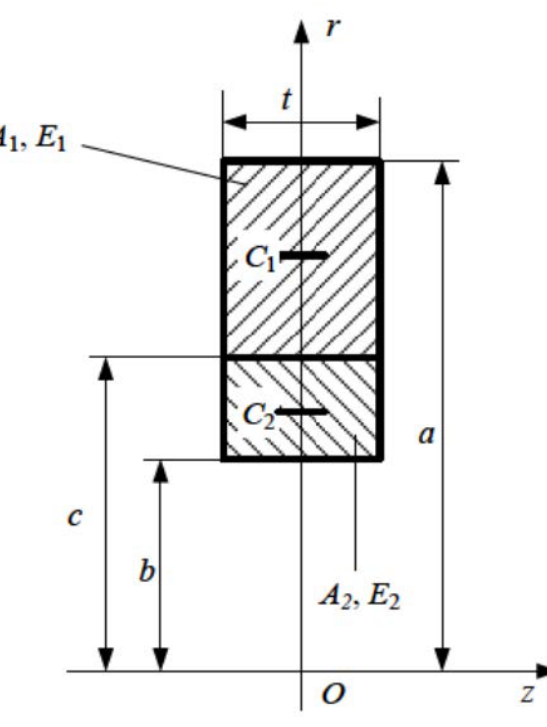
Figure 4: The cross section of the curved composite beam.